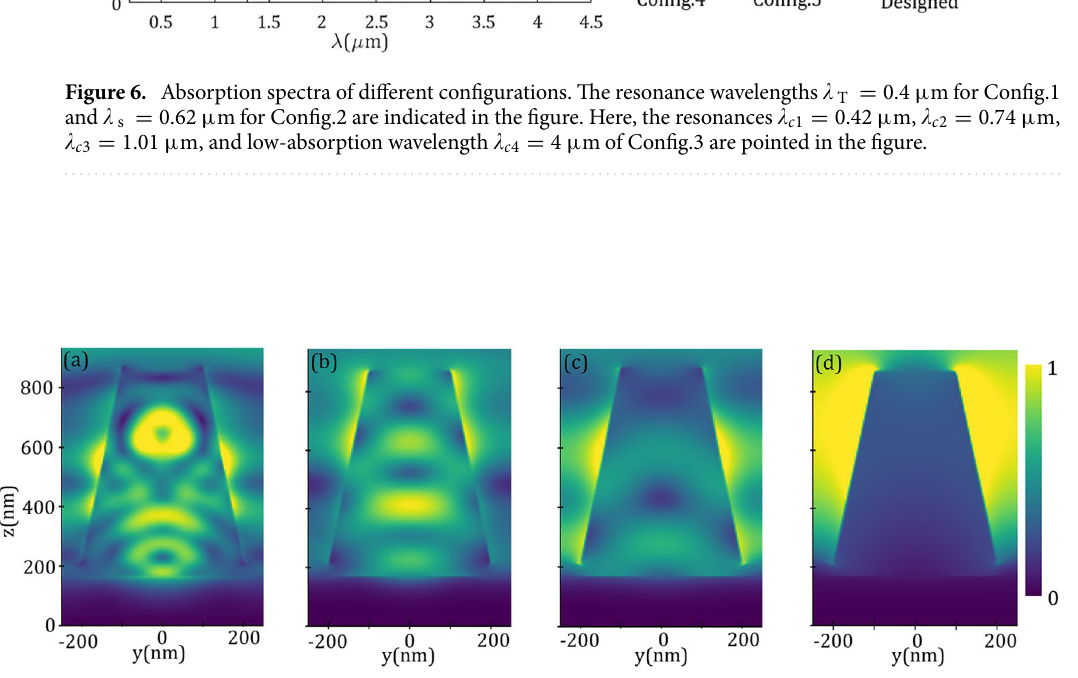
Figure 7. Electric field | E | distributions of the conical Ti O 2 metasurface (Config.3 in Fig. 6) at yz -plane for resonance wavelengths, ( a ) (cid:31) c 1 = 0.42 µ m , ( b ) (cid:31) c 2 = 0.74 µ m , ( c ) (cid:31) c 3 = 1.01 µ m , and ( d ) an arbitrary wavelength (cid:31) c 4 = 4 µ m taken from low-absorption